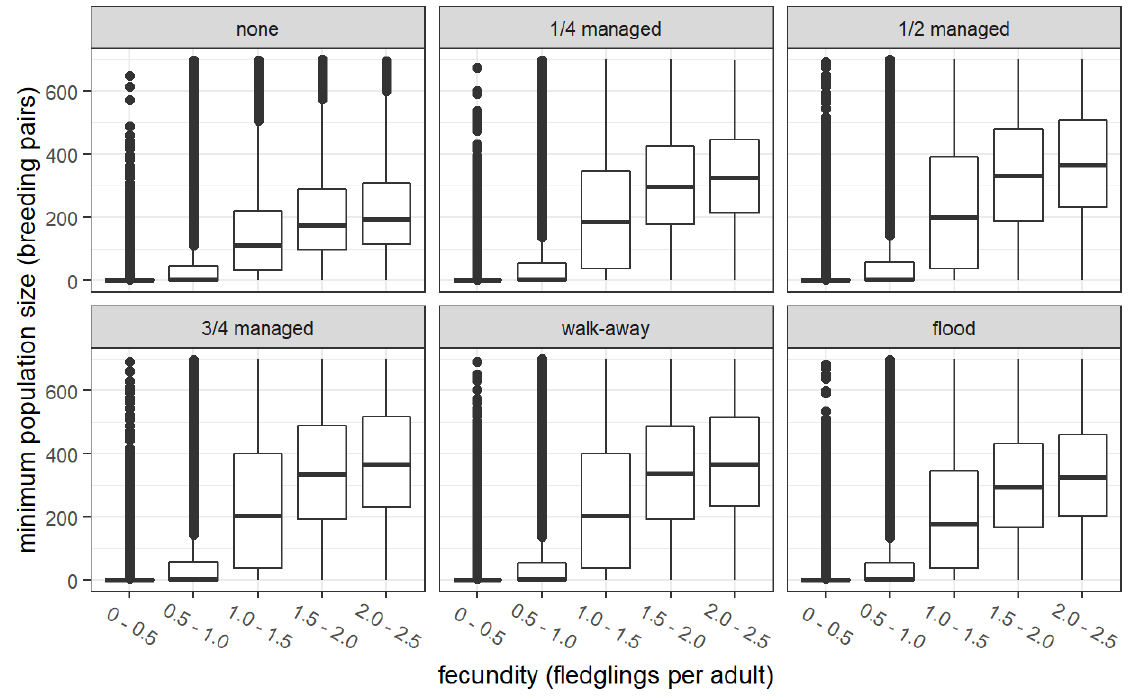
Figure A2.1. Minimum number of breeding pairs over the duration of the simulation. Results are summarized under the full range of parameter uncertainty for six potential habitat management scenarios. Results are grouped by fecundity ranges achieved after simulated impact from Brown-headed Cowbird brood